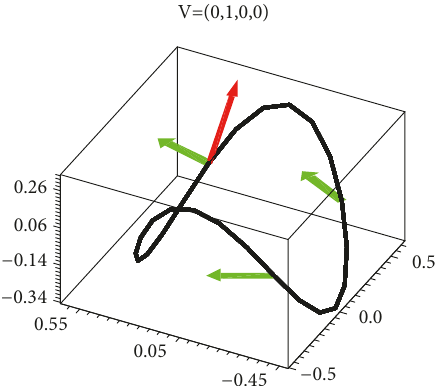
Figure 1: Red vector is 𝛾 󸀠 (0) = {1, −1,0,−2} , and green vectors are magnetic fields 𝑉 = {0,1,0, 0} .